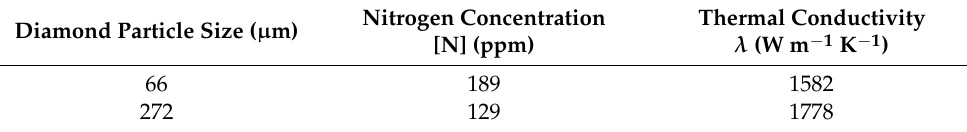
Table 1. Material properties of the diamond